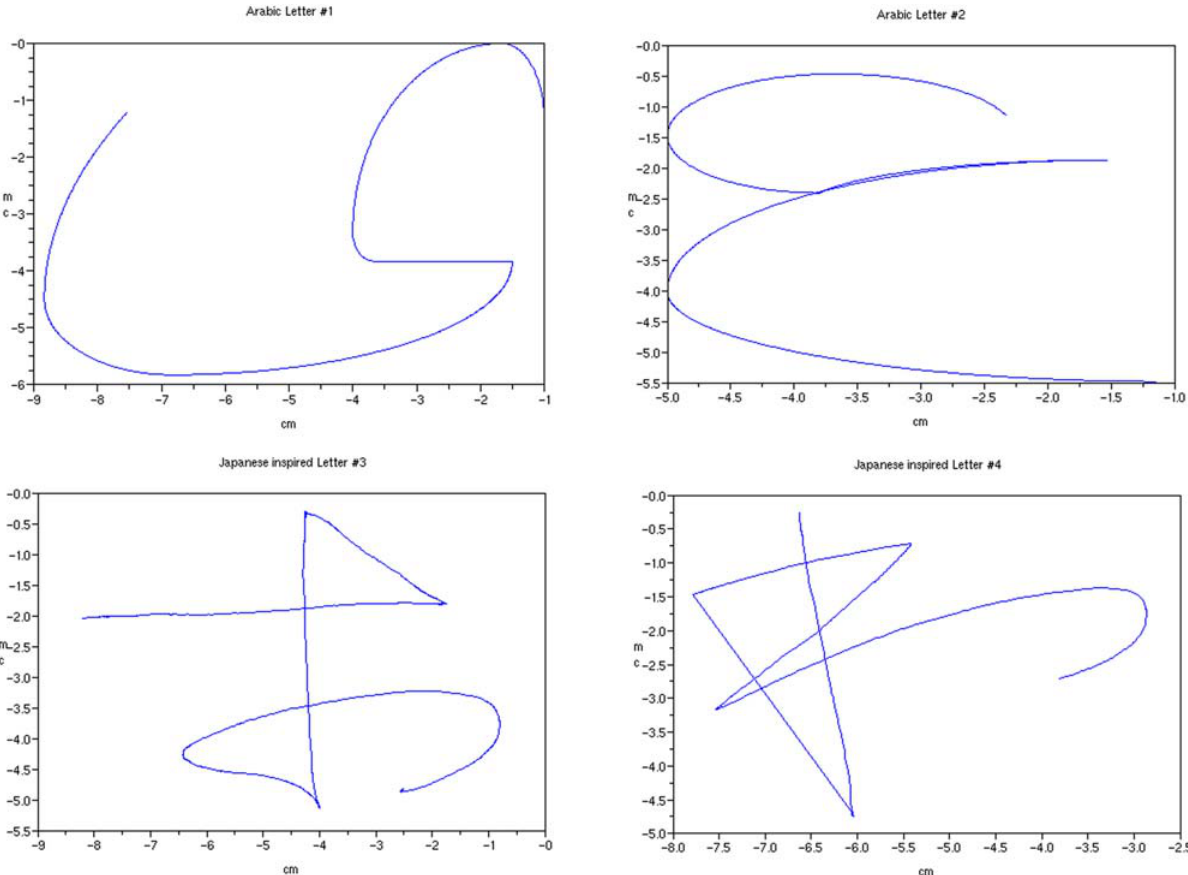
Figure 3. Letters proposed in experiment 1: Letters 1 and 2 are Arabic and letters 3 and 4 are ‘‘Japanese-like’’ letters.